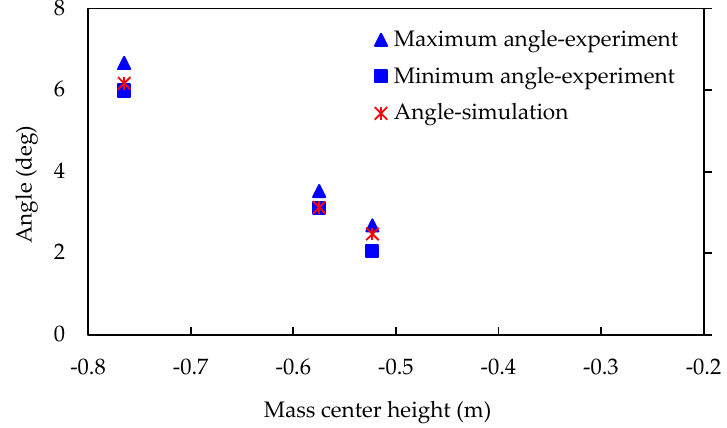
Figure 20. Effects of the mass center on the angular response of the platform.